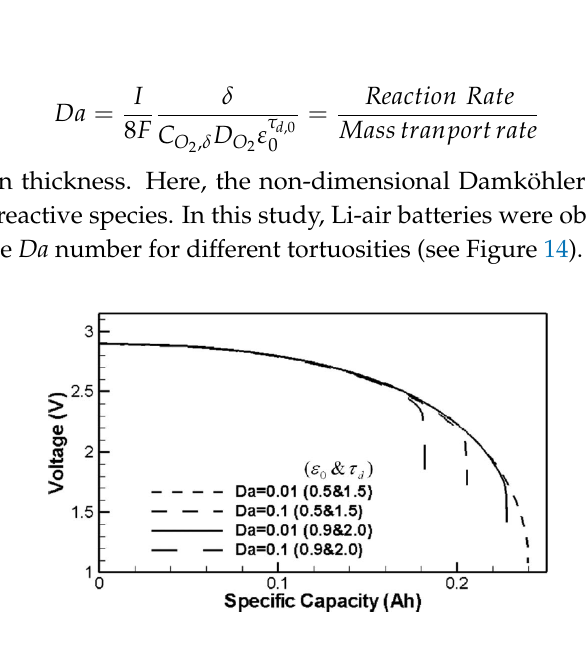
Figure 14. Li-air battery performance with varying Da numbers. Republished from Wang and Cho [22] with permission of The Electrochemical Society, conveyed through Copyright Clearance Center, Inc.